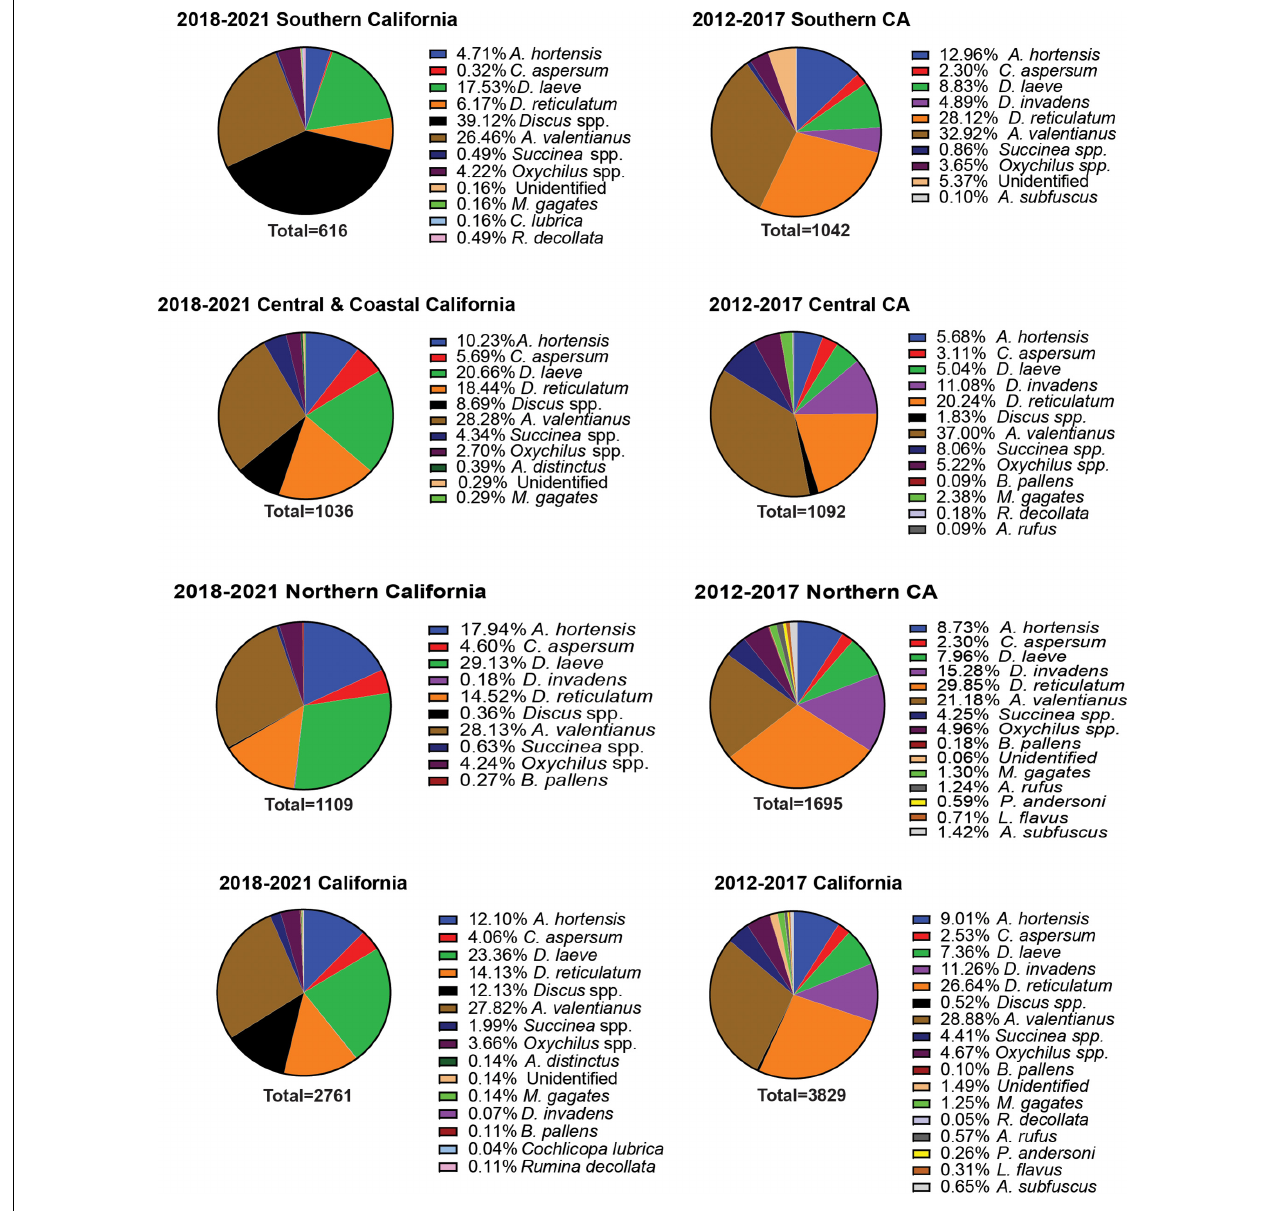
FIGURE 1 | Percent recovery of terrestrial gastropods from different geographical regions of California during the 2012–2017 and 2018–2021 surveys. Surveys were performed during late fall or winter. Survey methods included 1 human hour searching for gastropods throughout each nursery. Collected gastropods were sorted by species and were taken back to the laboratory for later verification of species